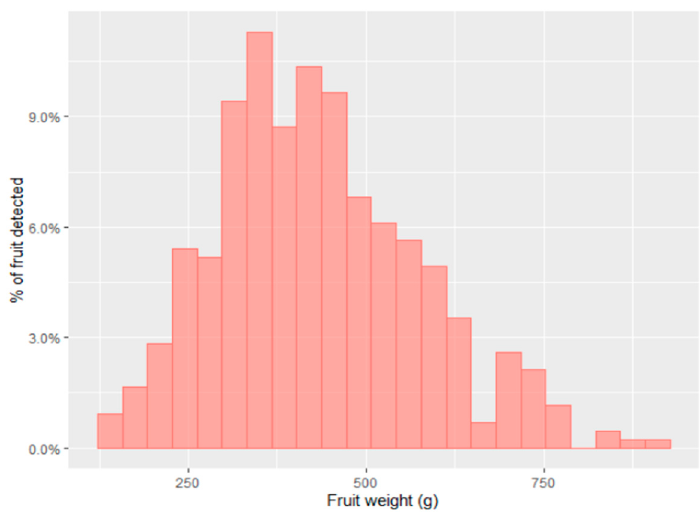
Figure 9. Estimated weight of mango fruit on-tree, based on lineal dimensions of fruit assessed using a ToF camera for estimation of camera to fruit distance and an RGB camera for estimation of fruit size in pixels.